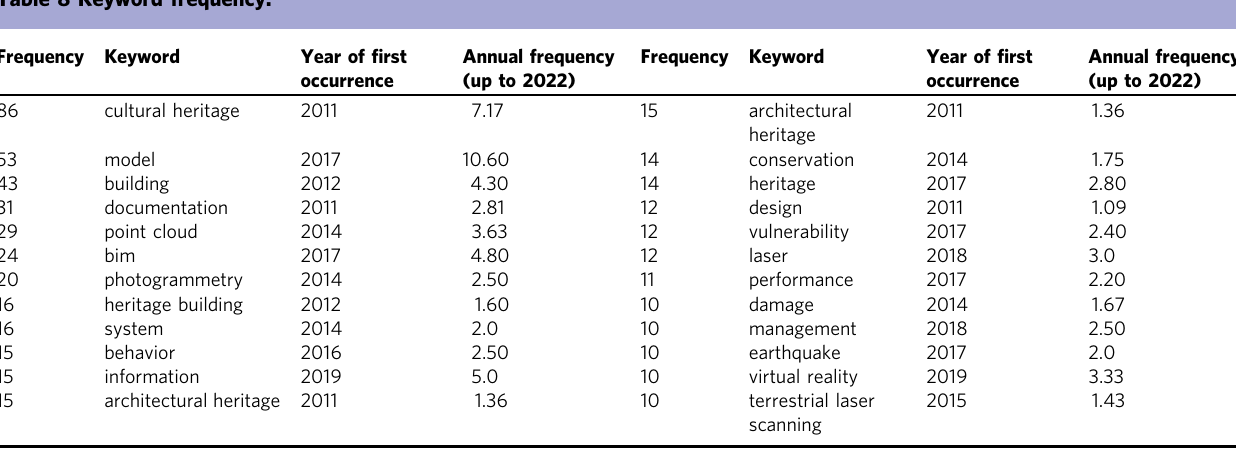
Table 8 Keyword